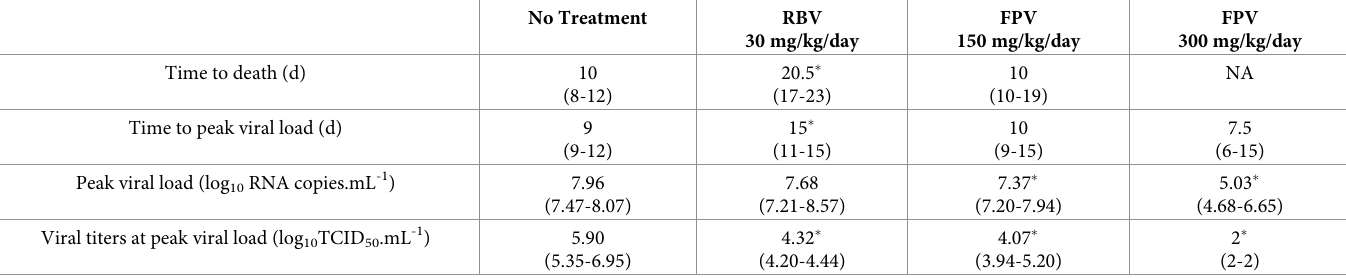
Table 1. Description of viral kinetics. Median (min-max). � = p < 0.05 to untreated (Log-rank test for survival, Wilcoxon test for viral load and